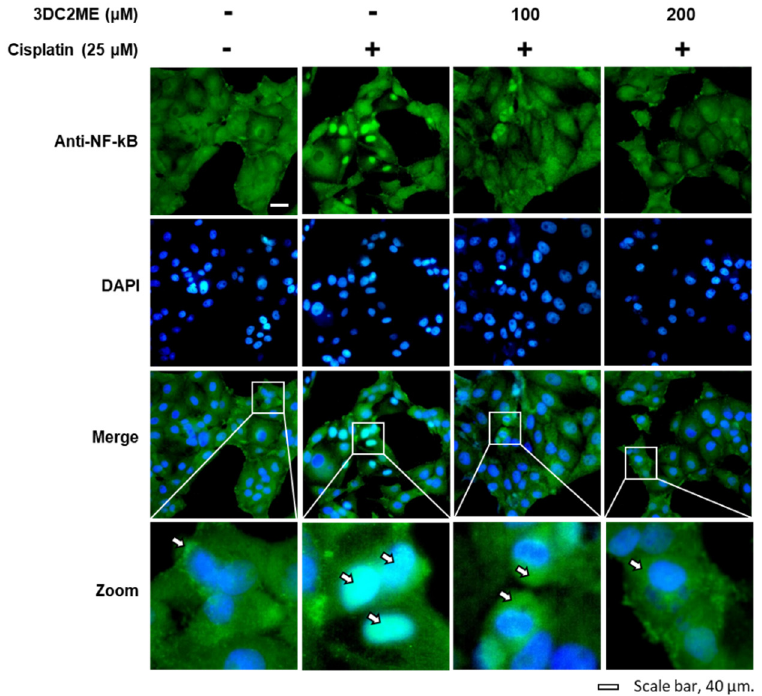
Figure 6. Effects of 3DC2ME and/or cisplatin on nuclear translocation of NF-kB in LLC-PK1 cells. LLC-PK1 cells were exposed to 25 μ M cisplatin in the presence or absence of 100 or 200 μ M 3DC2ME, and immunofluorescent staining was performed using antibodies for NF-kB that was visualized with a goat anti-rabbit IgG-heavy and light chain antibody FITC conjugate (green) and mounted with ProLong ® Gold antifade reagent with DAPI stained nucleus (DAPI). Representative images were obtained using an IX50 fluorescent microscope. The white arrows indicate the presence of NF-kB (scale bar = 40 μ m).